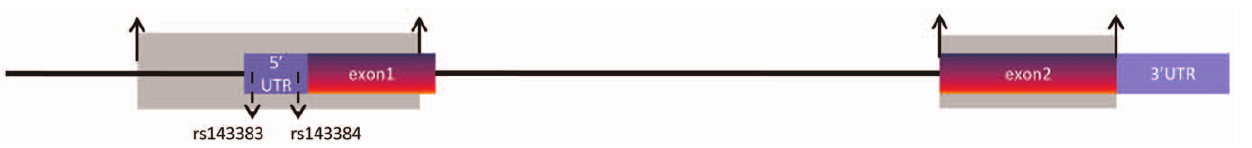
Figure 1. Structure of the human GDF5 gene structure. The human GDF5 gene is composed of two exons. The two regions sequenced in this study are denoted by the two rectangles.